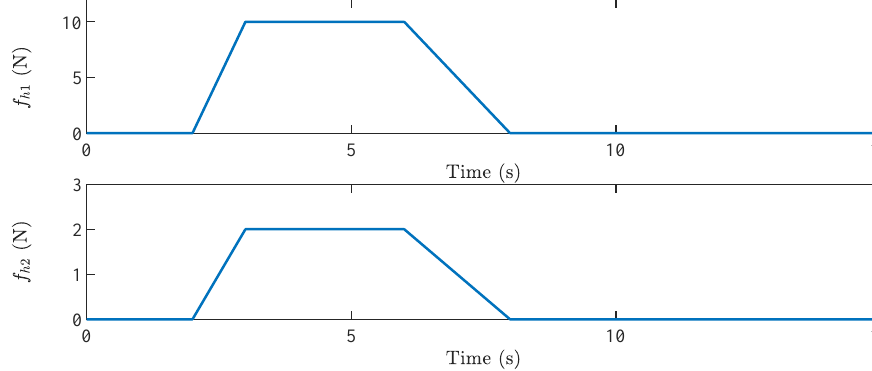
Figure 4. External operator forces F h in the x-direction and